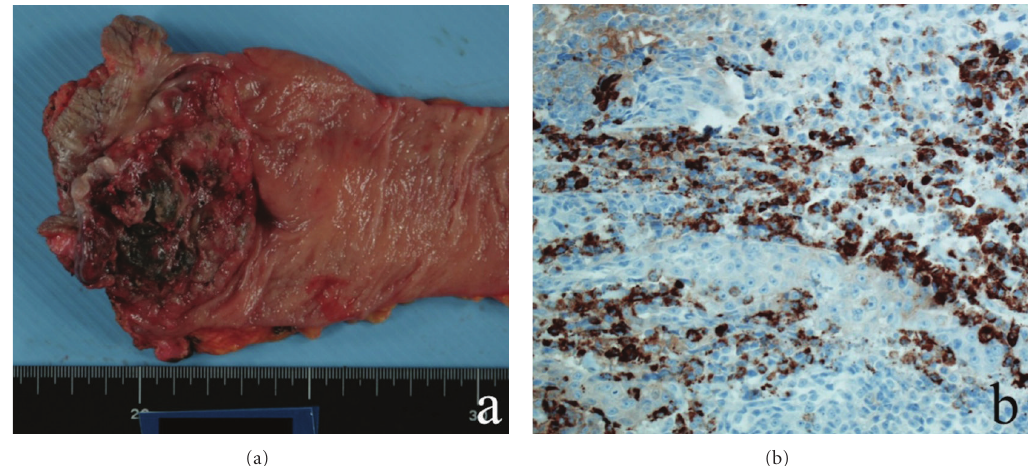
Figure 2: Case 2 pathological imaging. (a) Macroscopic image of the rectal tumor showing some pigmented lesions. (b) Rectal specimen is positive for the expression of HMB-45 ( ×